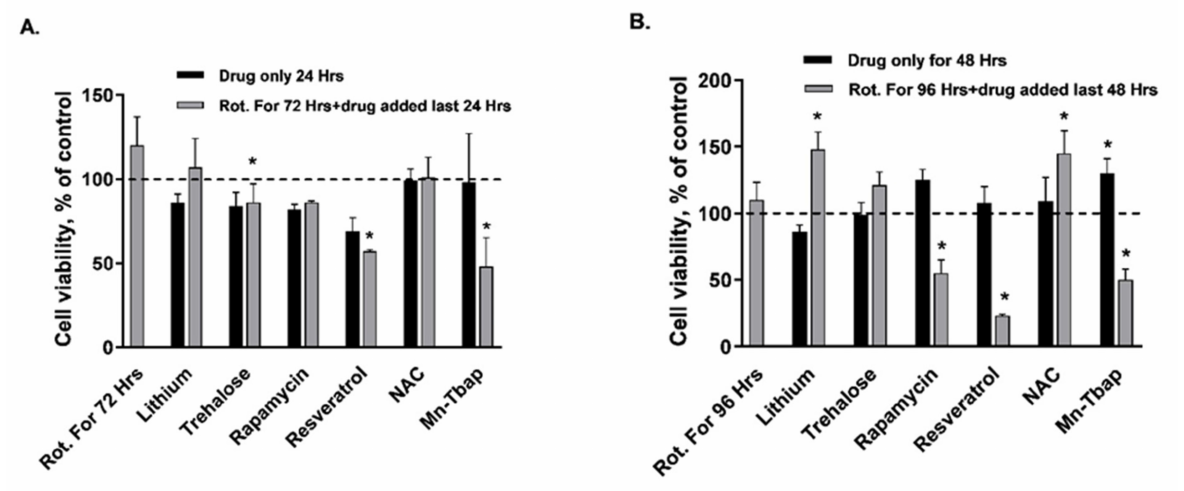
Figure 1. Effect of ROS scavengers/autophagy enhancers on cell viability pre and post exposure to 10 pM